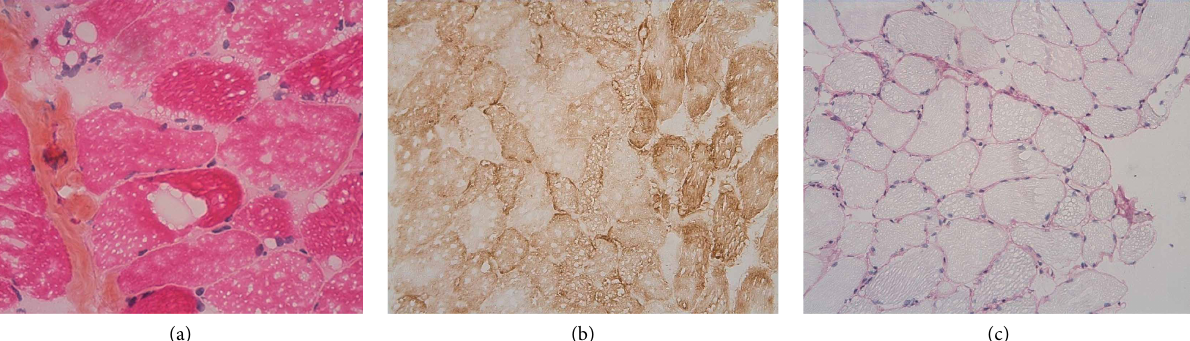
Figure 2: Pathology assessment of a muscle biopsy. (a) Stain:hematein eosin saffron; magnification: ×40. (b) Histochemical analysis of cytochrome oxidase; magnification: ×20. (c) Stain: periodic acid Schiff; magnification: ×20.